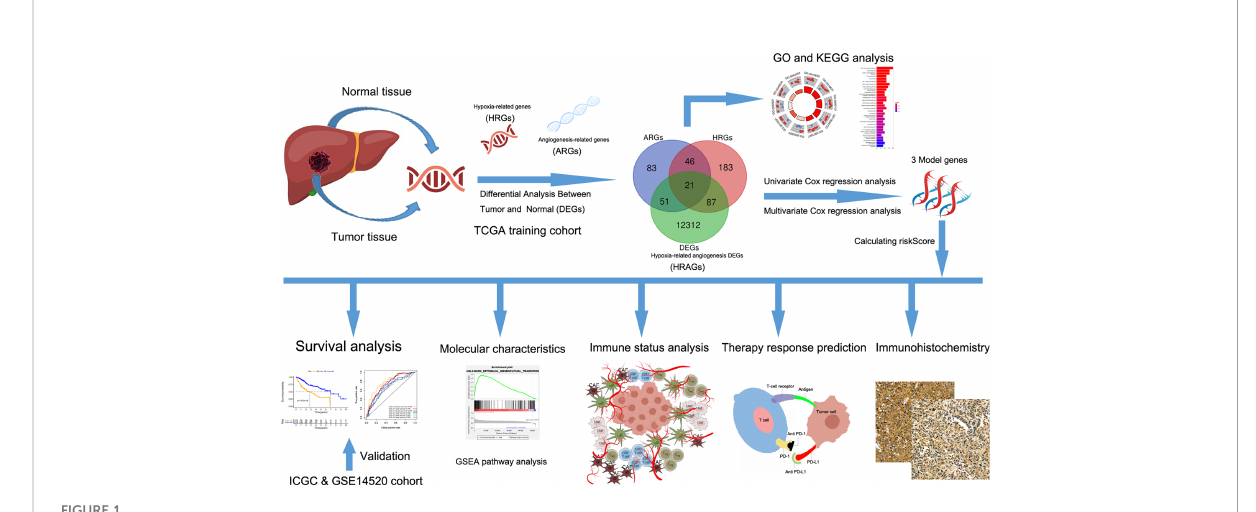
FIGURE 1 Flow chart of data collection and